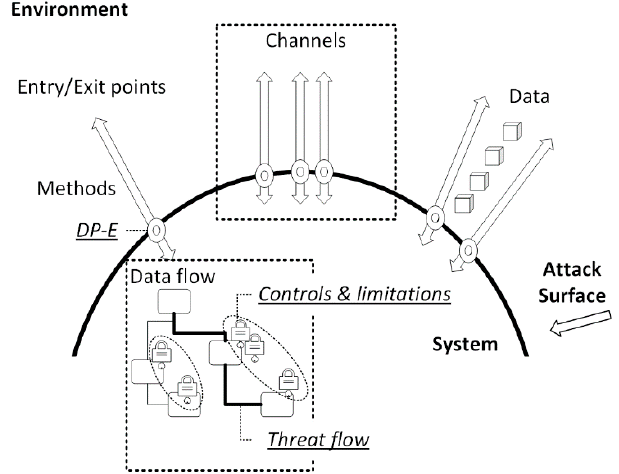
Figure 1. The main SPD multi-metric concepts of a system. The interaction points are located at the boundaries of the system’s surface. Controls are placed along the dataflow to protect the system. The damage potential-effort ratio ( DP-E ) represents the opportunity to exploit a dataflow.